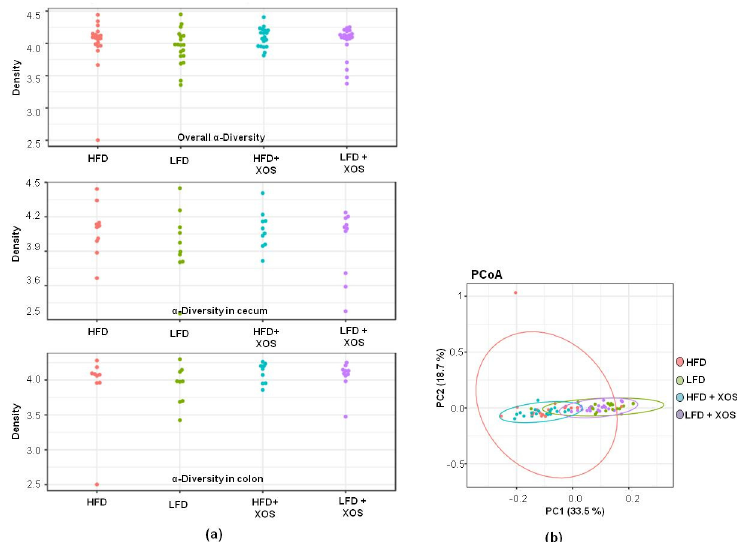
Figure 5. No significant associations were observed between the diets and the diversity of the gut microbiota. ( a ) The overall alpha-diversity (on top), alpha-diversity in colon (at the middle) and cecum (on bottom) of the gut microbiota. n = 10/diet group. The alpha-diversity of the gut microbiota was quantified with Shannon index using microbiome R/Bioconductor package; ( b ) The beta-diversity of the gut microbiota according to the principal component analysis (PCoA). PC1 indicates principal component 1 and PC2 principal component 2. n = 10/diet group. The analysis of beta-diversity was based on Bray–Curtis distance, and PERMANOVA was used for significance testing (adonis function in the vegan R package).